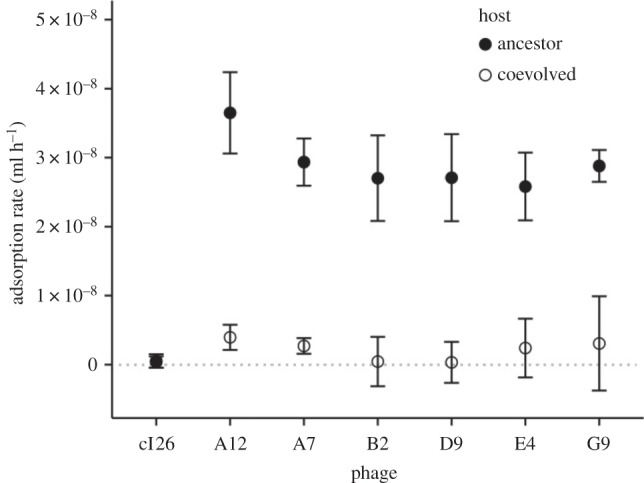
Virus and host coevolution alters adsorption rates. The evolved phages (A12, A7, B2, D9, E4 and G9), as a group, have increased adsorption rates relative to their ancestor (cI26) on both host types (see the text for statistical analyses). The coevolved host lowers the adsorption rates of the evolved phages relative to the ancestral host. No difference between the two hosts was detected for the ancestral phage; however, a difference was evident based on the growth rates of that phage. n = 4 for each evolved phage–host combination and n = 24 for each ancestor phage–host combination. Error bars are 95% confidence intervals (CIs).